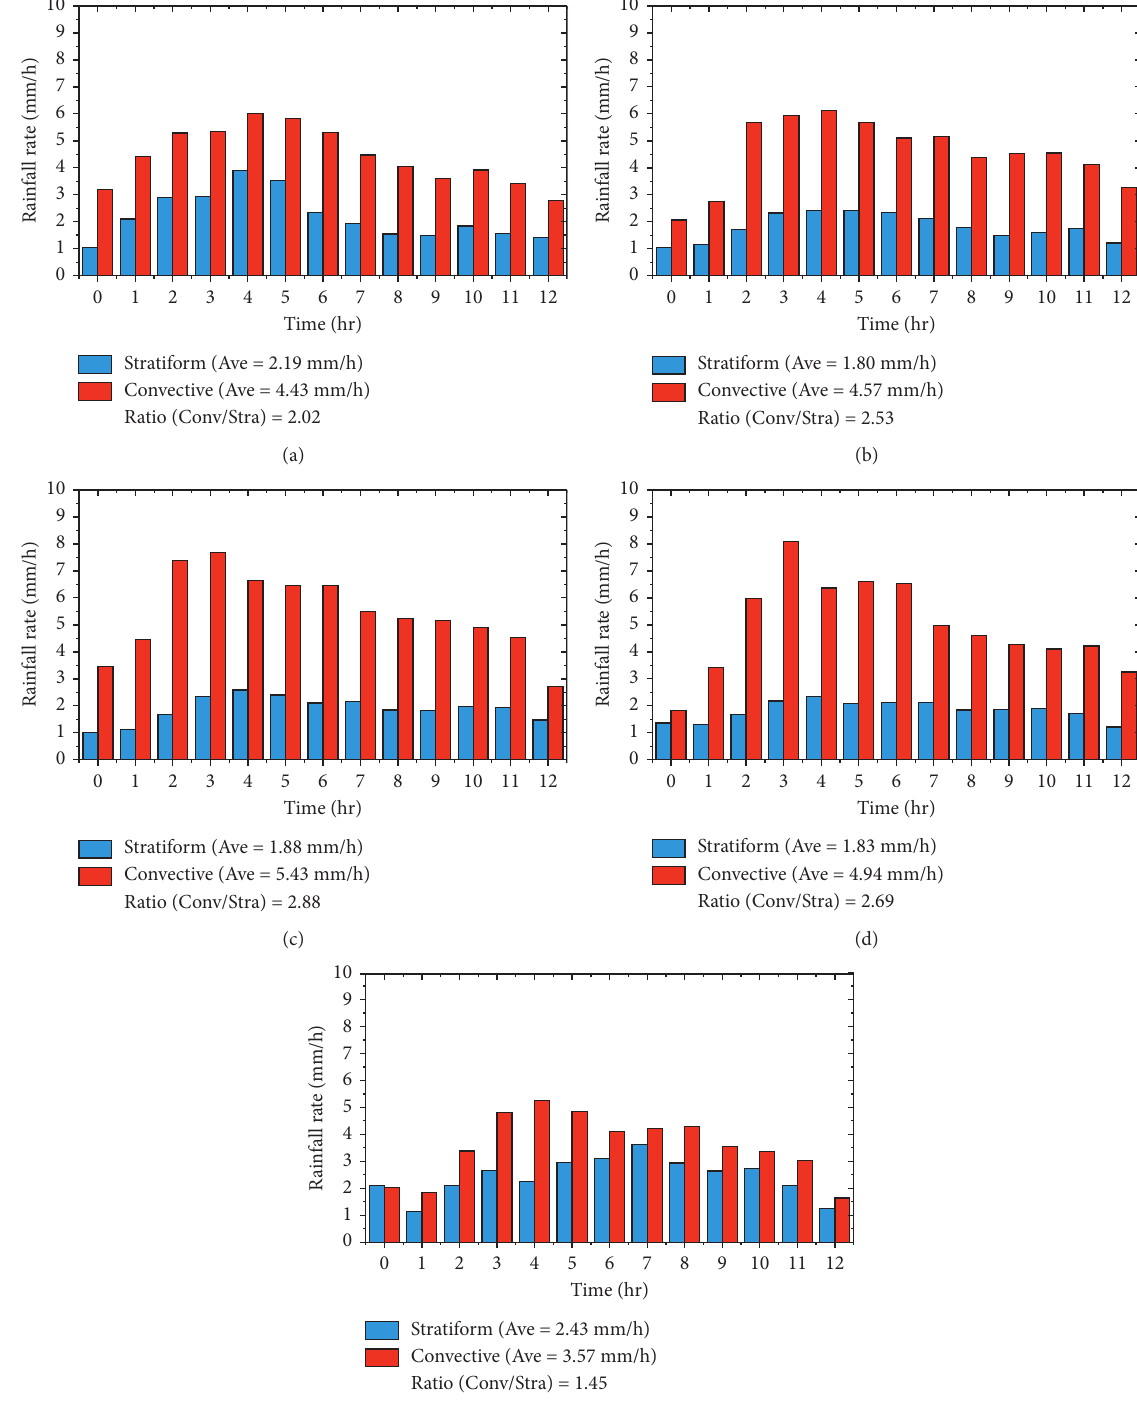
Figure 6: Hourly averaged precipitation rate over convective (red) and stratiform (blue) regions from (a) observations and (b) THOM, (c) MOR_G/H, (d) SBU-YLIN, and (e) WDM6_G/H scheme. The mean values in the upper right corner are the time- and domain-averaged rain rates over convective and stratiform regions during 00: 00–12:00 UTC 30 June